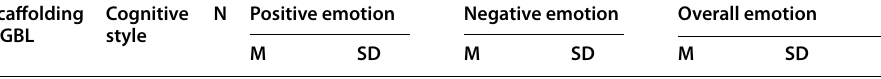
Table 5 The mean and standardized deviation of learning emotion between scaffolding DGBLs and cognitive styles Scaffolding